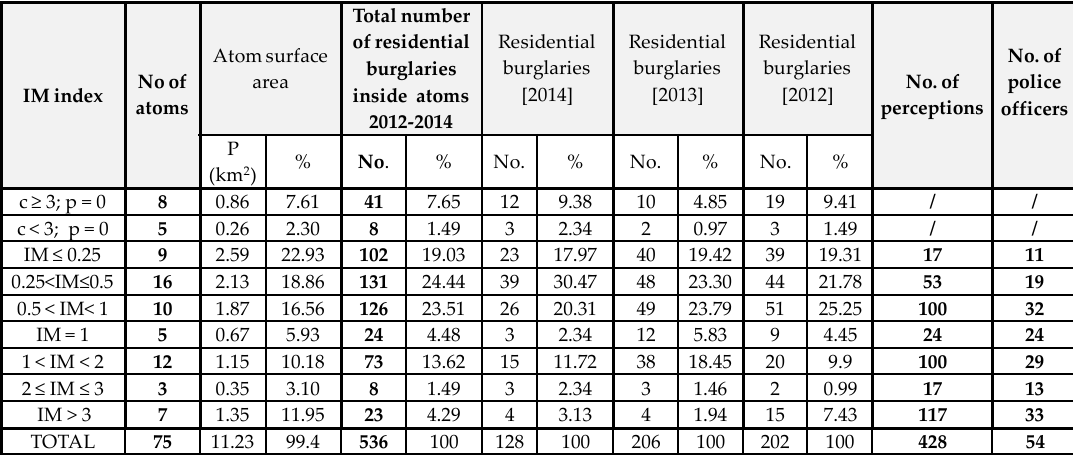
Figure 3. Detailed presentation of research results.